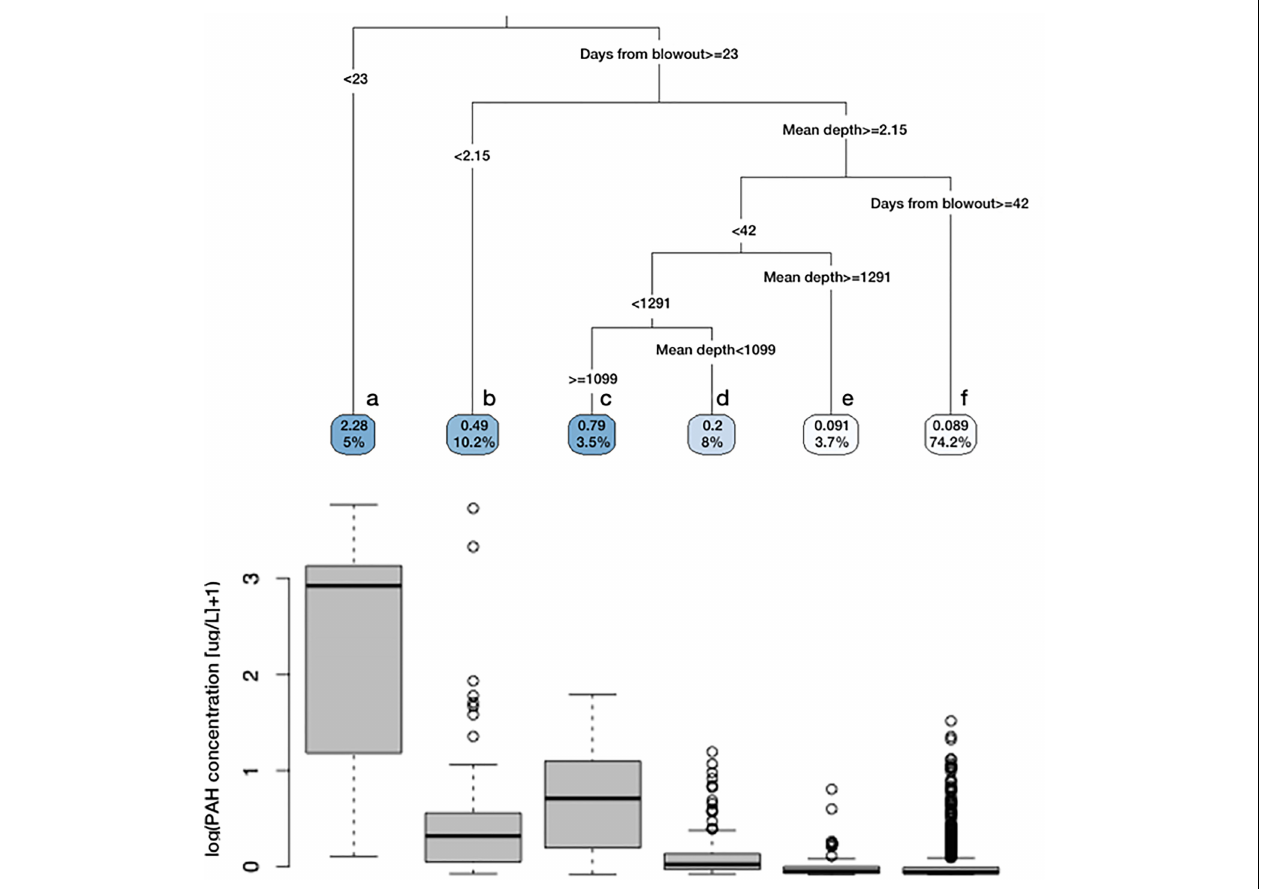
FIGURE 3 | Factors explaining oil distribution during the Macondo blowout. Regression tree of the log-transformed concentration [log( µ g/l + 1)] of polynuclear aromatic hydrocarbon (PAH) as response variable against depth of the sample [m], time from the blowout [days], distance from the wellhead [km], subsea dispersant injection (SSDI, [gal]), and surface dispersant application [gal] as explanatory variables. The numbers in each terminal leaf (or node) are the mean concentration of PAH and the percentage of samples; the darker leaf shade, the higher the explanatory power of the branch. Box plots show the distribution of PAH concentration values in each node ( n = sample size). The tree partitions 1428 samples collected from May 5th to July 12th within 10 km from Macondo and explains 39% of the variance in PAH concentrations. No effect of SSDI volume is detected within the six main nodes